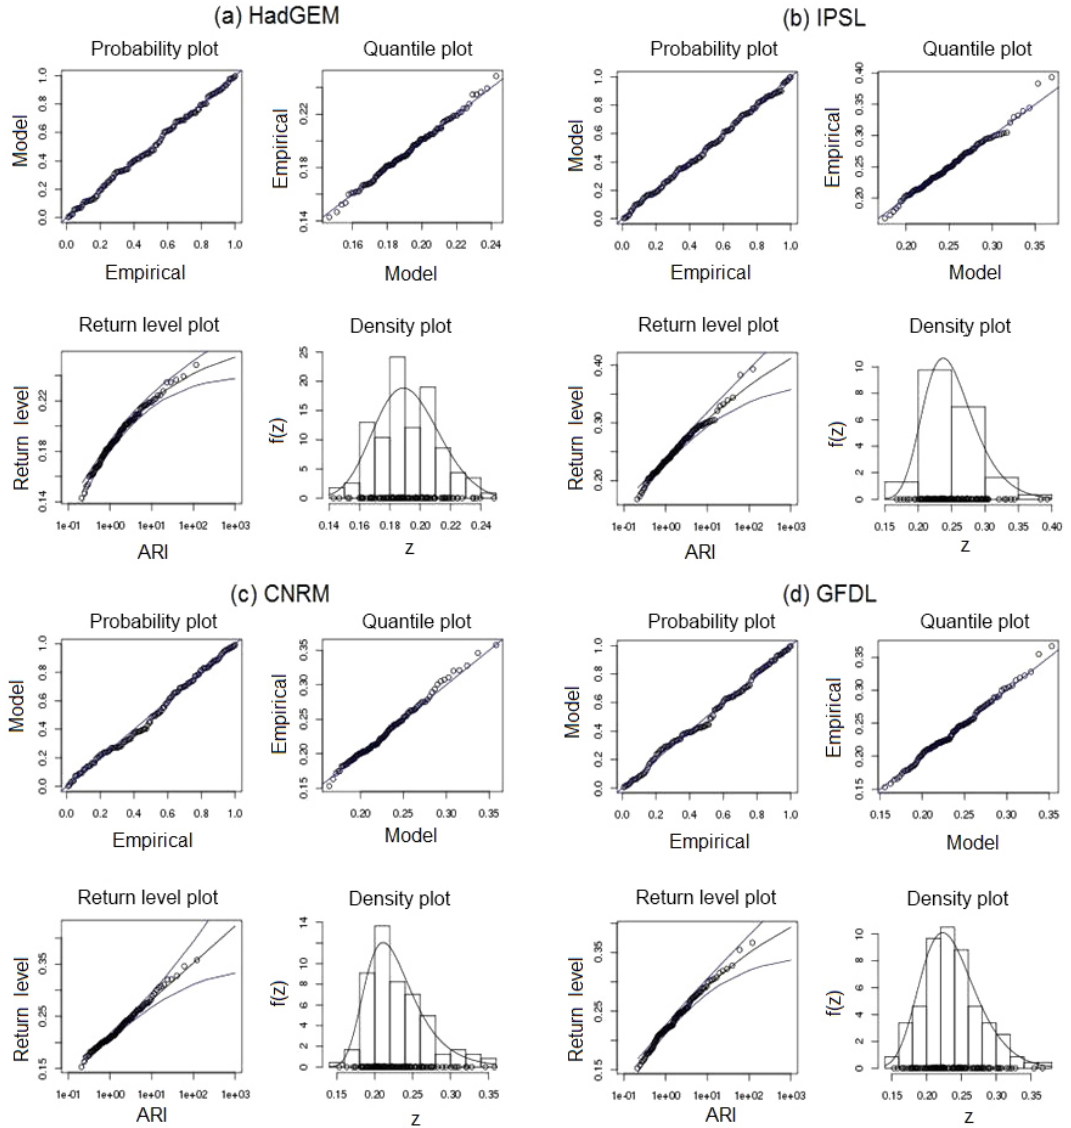
Figure A2. Standard diagnostic plots for stationary fit to skew surge annual maxima from (a) HadGEM2-ES, (b) IPSL, (c) CNRM, and (d) GFDL simulations. The quantile and probability plots compare the theoretical distribution fitted to the data with the actual data and give an indication of confidence in the fit of the return